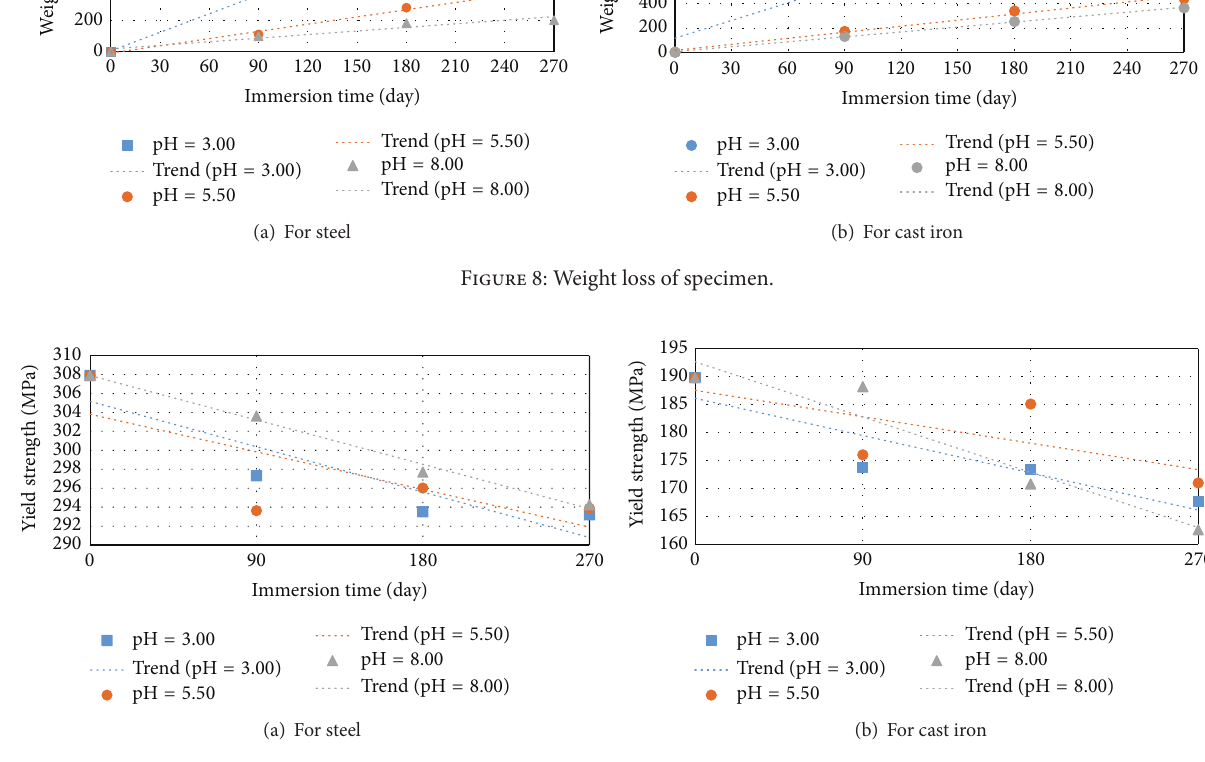
Figure 9: Tensile strength reduction of